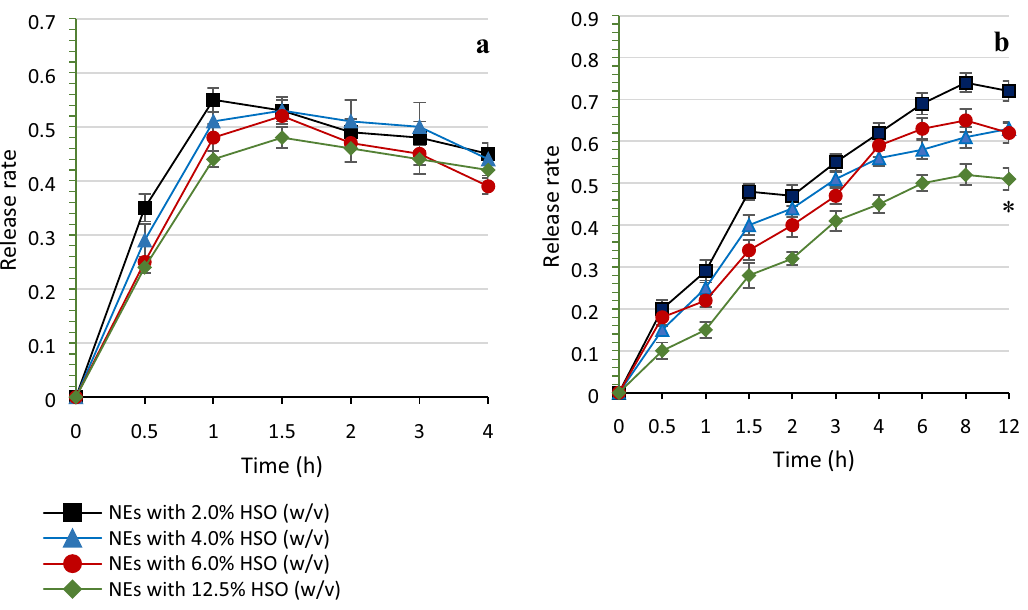
Figure 6. In-vitro release profile of linoleic acid from nanoemulsion with different concentrations of HSO as a function of incubation time in simulated gastrointestinal fluids ( a : pH = 1.3, b : pH = 7.0). Each point represents the mean value ± SD ( n = 3). *Significant values ( p < 0.05) compared to other HSO concentrations (2, 4 and